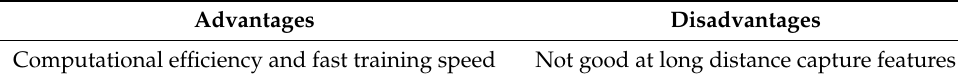
Table 7. The advantages and disadvantages of